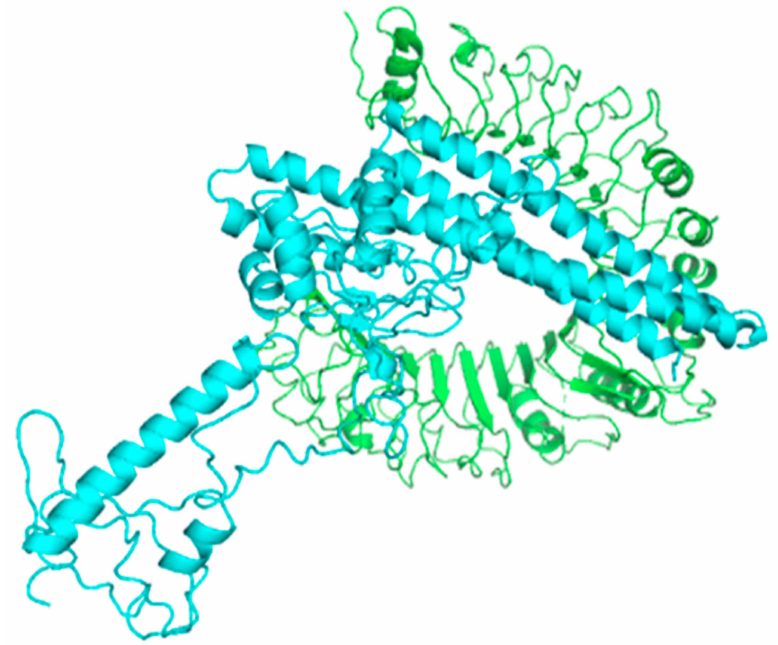
Figure 7. Validation of the three-dimensional structure of the vaccine constructed. ( A ) ProSA web evaluation of the vaccine structure (Z-scores − 9.1); ( B ) investigation of the protein structure using the Ramachandran plot following molecular optimization; ( C ) ProSA graphical plot (local model quality); ( D ) ERRAT server predicted the overall quality of the 3D structure.